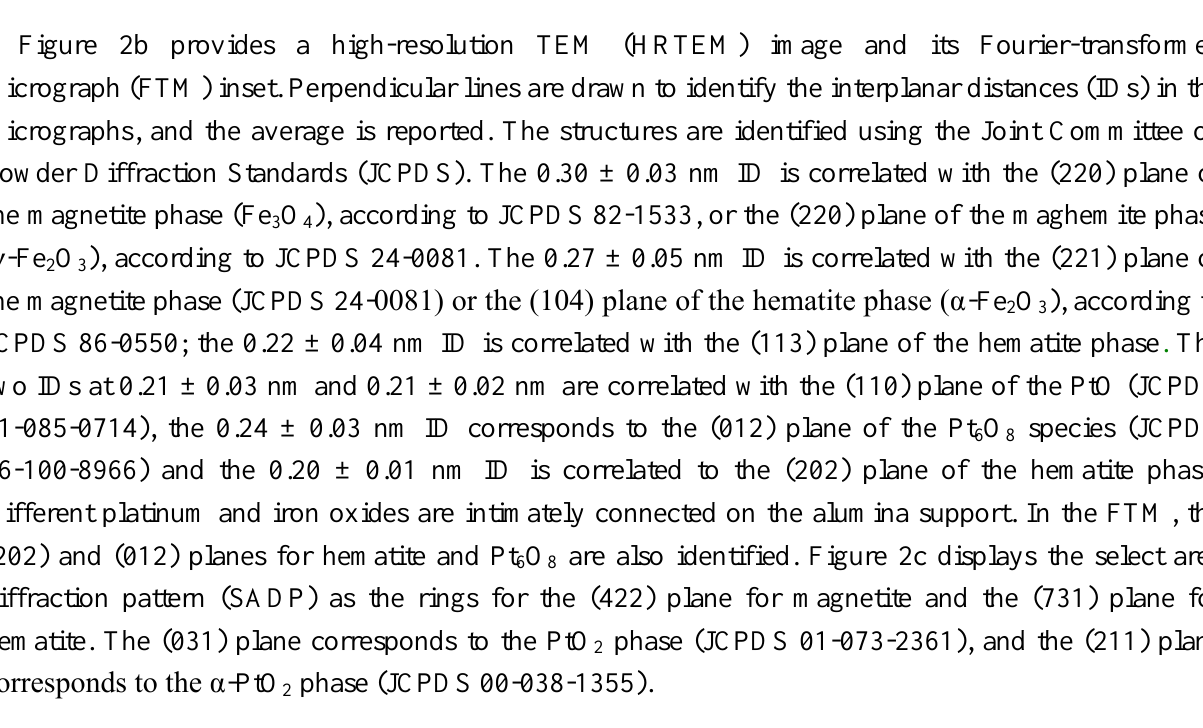
O with Pt-Fe oxide nanoparticle; 2 3